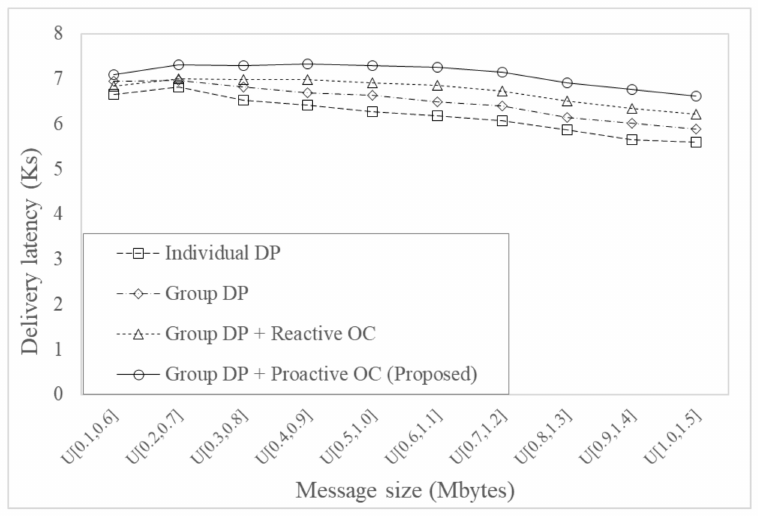
Figure 10. Delivery latency for varying message